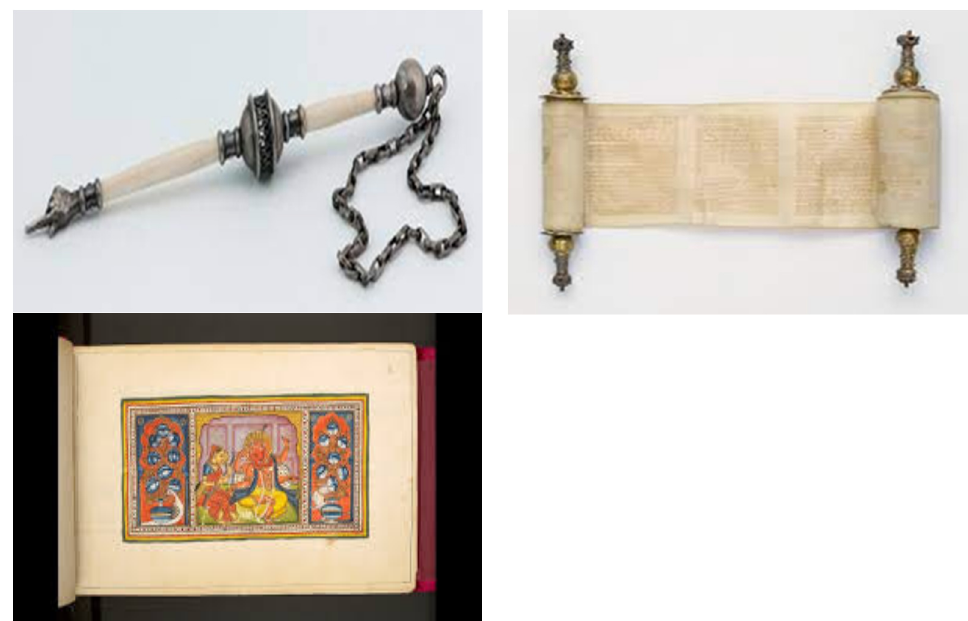
Figure 3. Sacred icons being used by astronauts during their space mission, public domain.